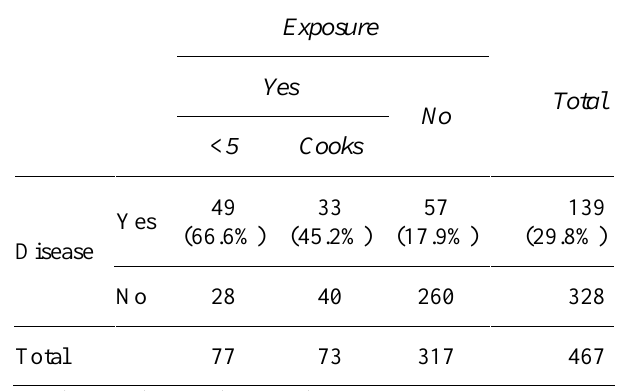
Table 8: Sample distribution and ARI prevalence (in